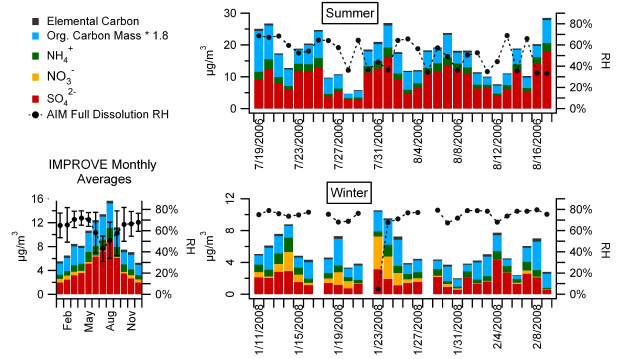
Fig. 4. Daily PM 2 . 5 Filter based measurements made on site at Look Rock near Great Smoky Mountains National Park from Lowenthal et al. (2009) and the IMPROVE network. IMPROVE values are computed as the average of all days within each month during the period from 1997–2006 in which NH + ions were mea- 4 sured. The black traces showing expected full dissolution RH were calculated for the measured sulfate/nitrate/ammonium proportions using the Aerosol Inorganics Model